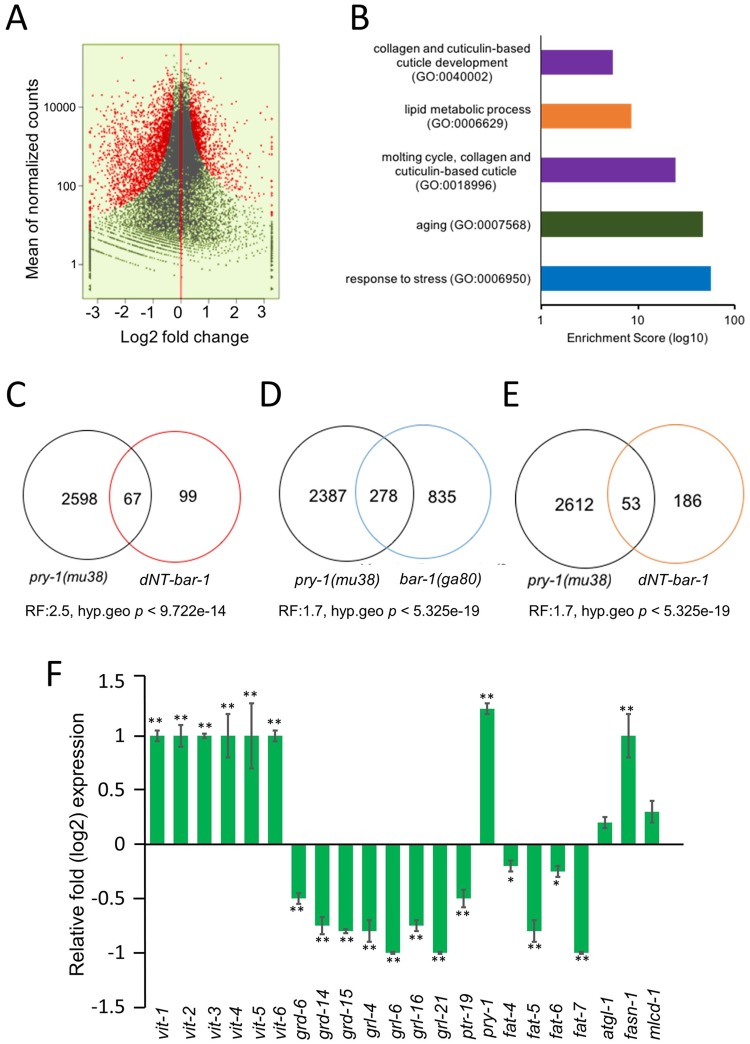
pry-1(mu38) transcriptome analysis.(A) Scatter plots of differentially expressed genes in pry-1(mu38). Red dots mark significantly altered transcripts with a FDR p-adj of < 0.05, whereas black dots mark transcripts that are not significantly altered (FDR p-values of > 0.05). (B) Selected GO categories enriched in pry-1(mu38) targets are identified by GO Amigo, (p-adj < 0.05). (see S4 Table for a detailed list). (C-E) Venn diagrams showing the overlap between pry-1(mu38), hs::dNT-bar-1, and bar-1(ga80) transcriptional targets. P values are shown in each case. (C) Overlap between pry-1(mu38) and hs::dNT-bar-1whole animal transcriptome data [36]. (D) Overlap between pry-1(mu38) and bar-1(ga80) whole animal transcriptome data [37]. (E) Overlap between pry-1(mu38) and hs::dNT-bar-1 vulva and seam cell-specific transcriptome data [38]. (F) qPCR analysis of selected genes in the pry-1(mu38) mutant. Data represents the mean of at least two replicates and error bar represents the SEM. *p < 0.05, **p < 0.01.